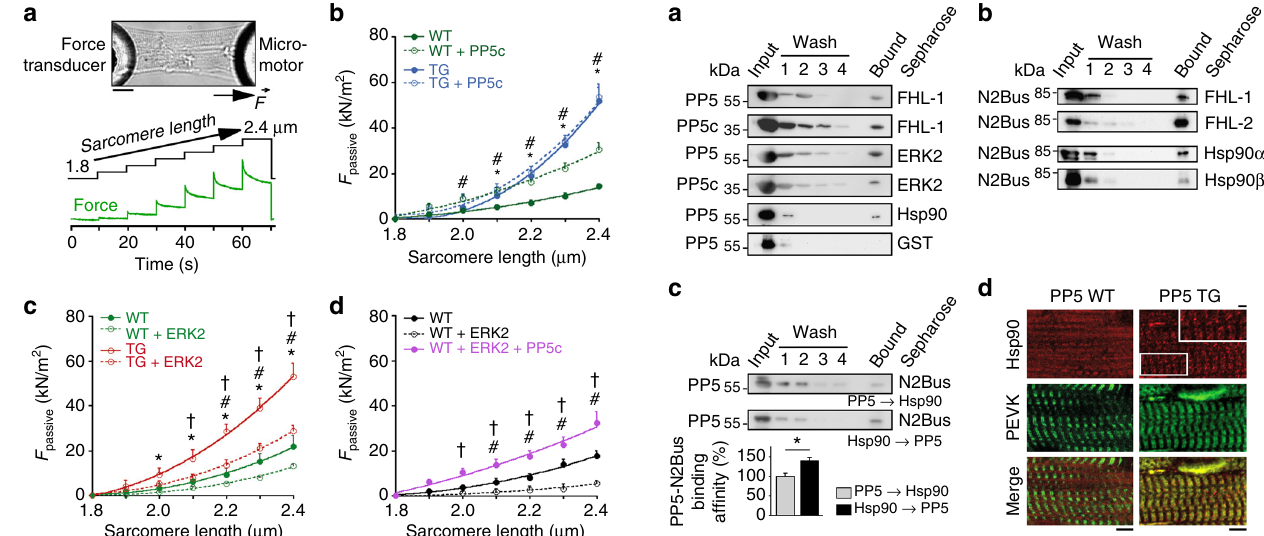
FHL-1-de fi cient hearts show reduced N2Bus phosphorylation .